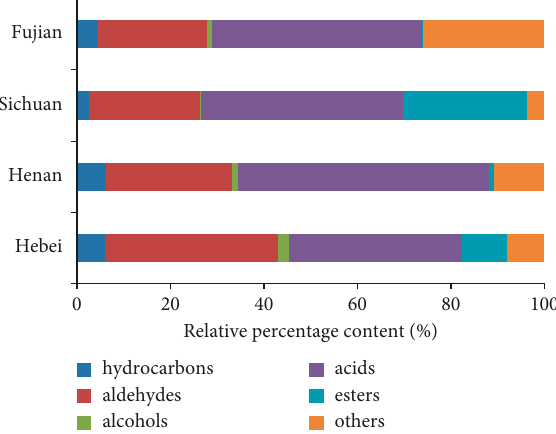
Figure 4: Relative contents of volatile compounds in T . fuciformis